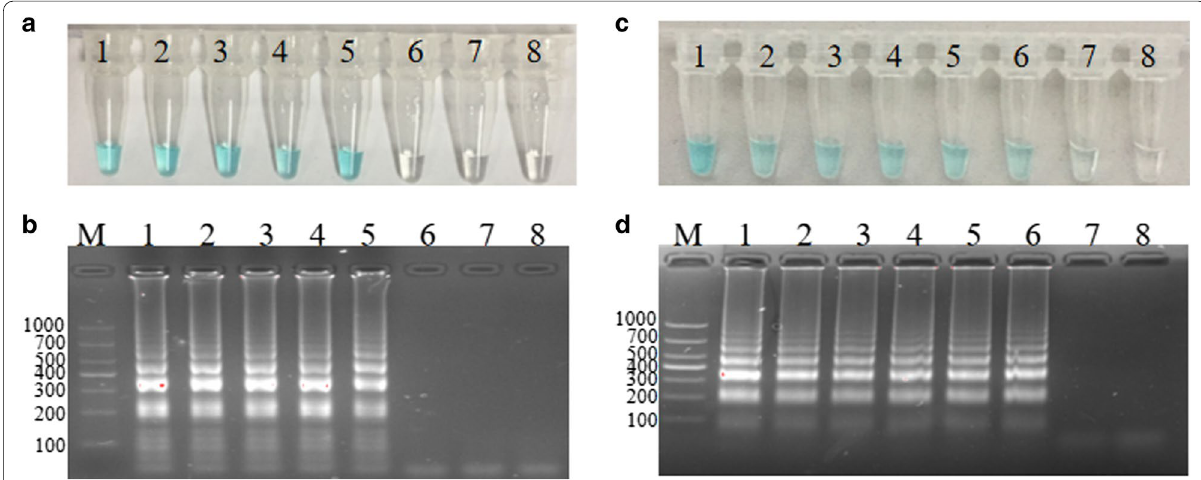
Fig. 5 Sensitivity analysis. Tenfold serial dilutions of the template (2.5 ng, 250 pg, 25 pg, 2.5 pg, 250 fg, 25 fg, 2.5 fg) or the pMD19-T plasmid(3.15 * 10 6 copies, 3.15 * 10 5 copies, 3.15 * 10 4 copies, 3.15 * 10 3 copies, 3.15 * 10 2 copies, 3.15 * 10 copies, 3.15 copies) were added to standard MCDA reactions and incubated at 61 °C for 1 h, respectively. Diagnosis techniques, including colorimetric indicator ( a , c ) and gel electrophoresis (b,d) were used for analysis of MCDA amplicons. Tubes ( a )/Lanes ( b ) 1–8 respectively represent S. agalactiae strain ATCC12386 DNA levels of 2.5 ng, 250 pg, 25 pg, 2.5 pg, 250 fg, 25 fg, 2.5 fg per reaction, and a blank control (DW). Tubes ( c )/Lanes ( d ) 1–8 respectively represent the reaction, and a blank control